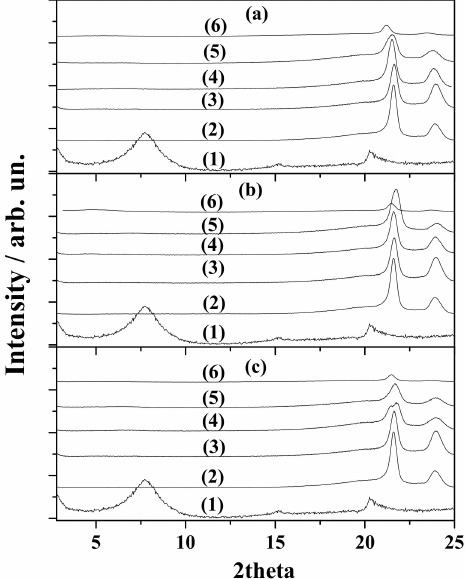
Figure 1. XRD patterns of ( a ) LDPENaMtTO, ( b ) LDPENaMtOO, and ( c ) LDPENaMtBO films. (1) NaMt as received, (2) pure LDPE film, (3) “blank” LDPENaMt film, (4) LDPENaMtEO20 film, (5) LDPENaMtEO40 film, and (6) LDPENaMtEO80